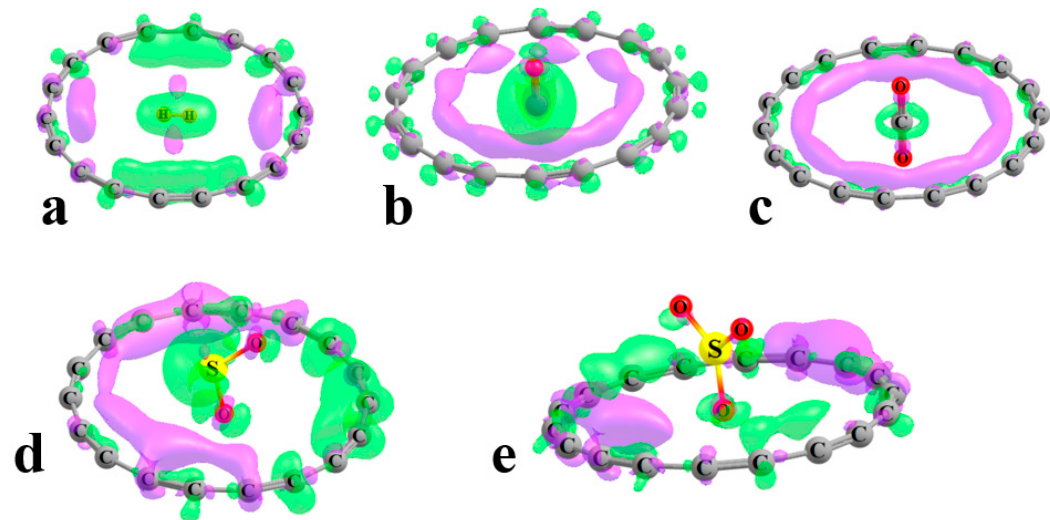
Figure 3. Shifts in electron density caused by complexation. Purple regions correspond to increase, with losses shown in green. The contours in each system are as follows in au: ( a ) H 2 , 0.00005, ( b ) CO, 0.00007, ( c ) CO 2 , 0.00020, ( d ) SO 2 , 0.00030, and ( e ) SO 3 , 0.00030.